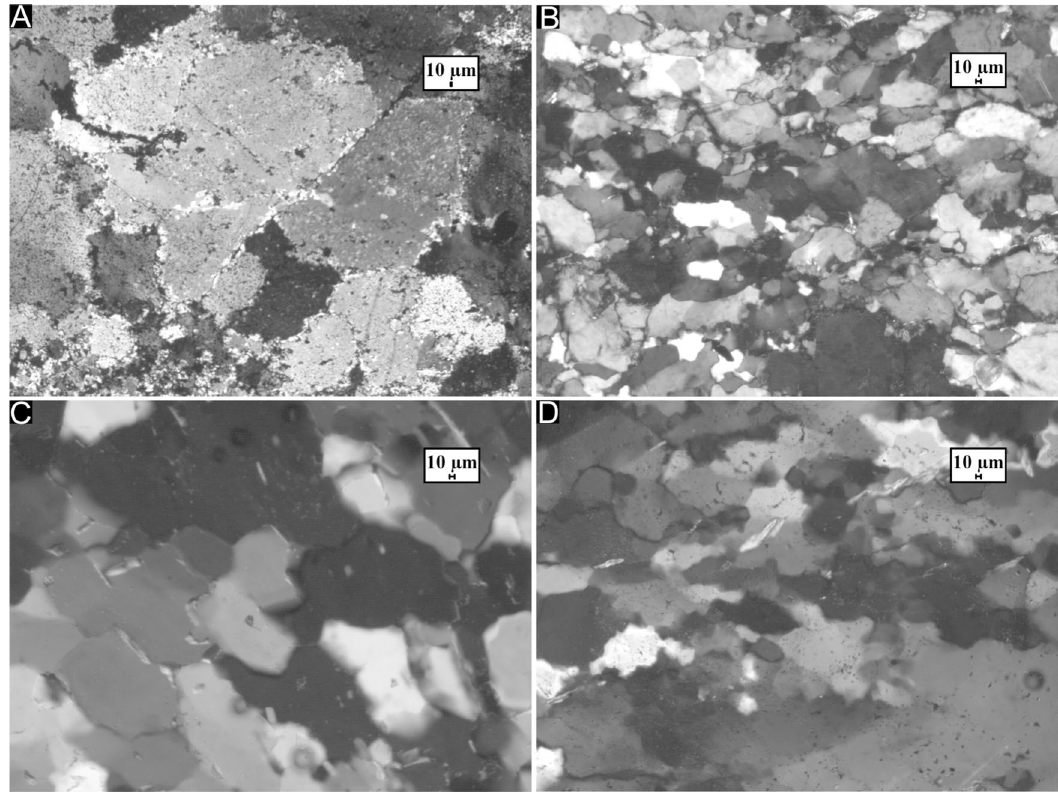
Figure 1. Thin section photomicrographs of four representative quartzite samples used for the purpose of this study, generated using Leica Qwin version 3 (Leica Microsystems); ( A ) RD 47: predominantly sedimentary quartzite from the Singhbhum Craton with limited deformation overprint. The average grain size is large but incipient recrystallization results in the development of prominent core-mantle structures with highly irregular grain boundaries. ( B ) RN 192: sheared quartzite from the Rengali Province. The average grain size is small and quartz grains are flattened and stretched in the direction of shearing, with prominent dextral asymmetry. ( C ) RN 36: quartzite from the Rengali Province which records a dominantly amphibolite facies deformation overprint. Grains are polygonal and equant with relatively straight boundaries implying deformation by dominantly static recrystallization. ( D ) RN 235: quartzite from the granulite unit of the central Rengali Province. Grains are amoeboid with highly irregular boundaries and comparatively larger sizes. Dynamic recrystallization at high temperatures implies that Grain Boundary Migration was the dominant deformation